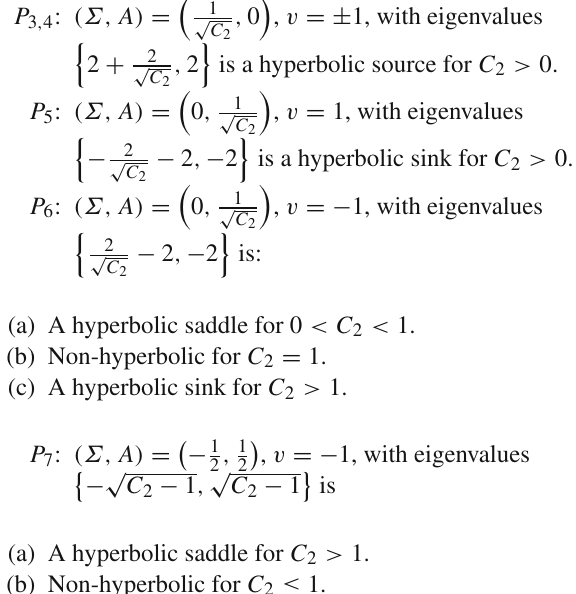
−√ γ − 1 , A = γ(γ(Σ + 2 ) − 2 ) , for C 2 = 0 . 5 , 1 , 2 y γ ∈ [ 1 , 2 ] , where v 0 = 4 (γ − 1 ) 3 / 2